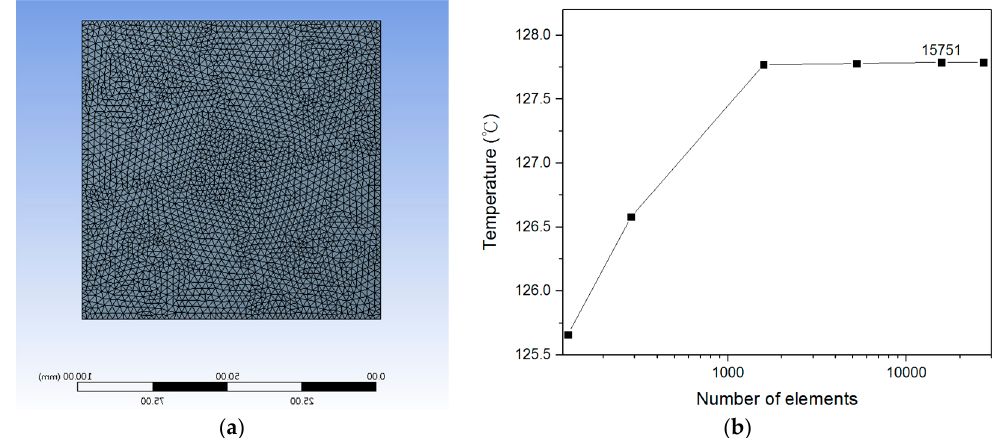
( b ) Figure 6. Temperature measurement of 60 V/0.15 A LED. ( a ) LED internal temperature field. ( b ) Aluminum fin temperature field. 4.4. Mesh Convergence Analysis Before starting the simulation, a mesh convergence analysis must be performed to justify the particular mesh used for the simulation. The mesh and convergence analysis result of the single chip